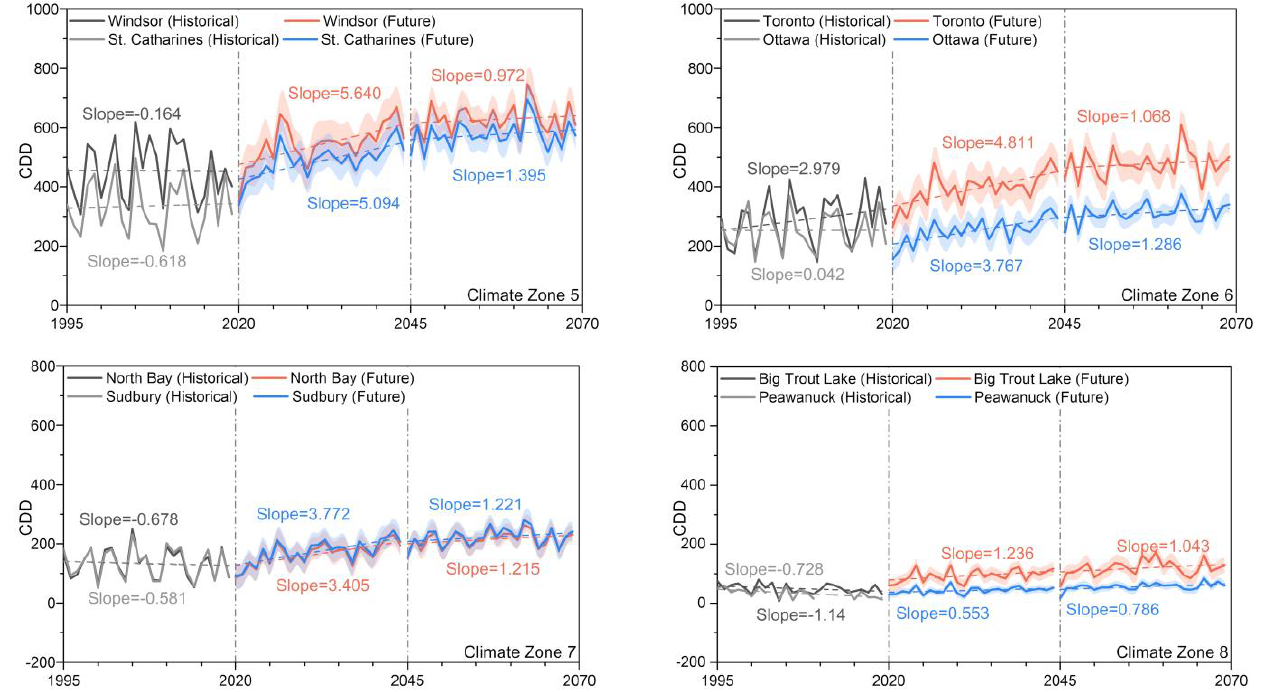
Figure 9. Historical (1995–2019) and future (2020–2069) annual CDD from climate zones.